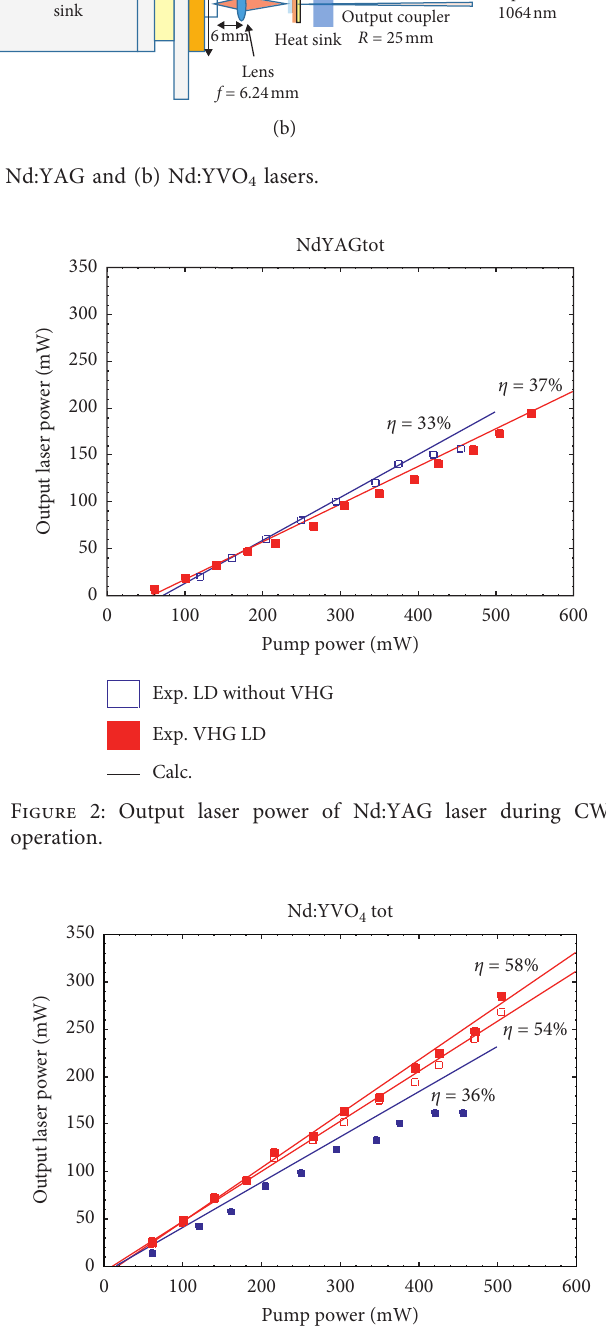
4 laser during CW